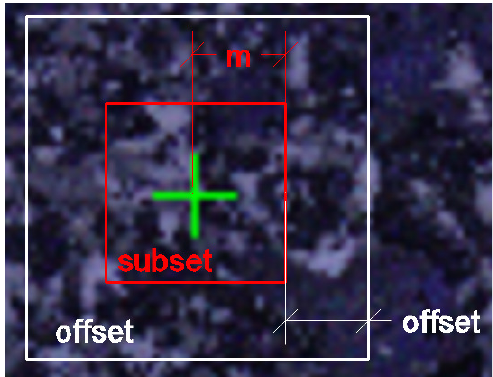
Figure 3. Definition of the subset and